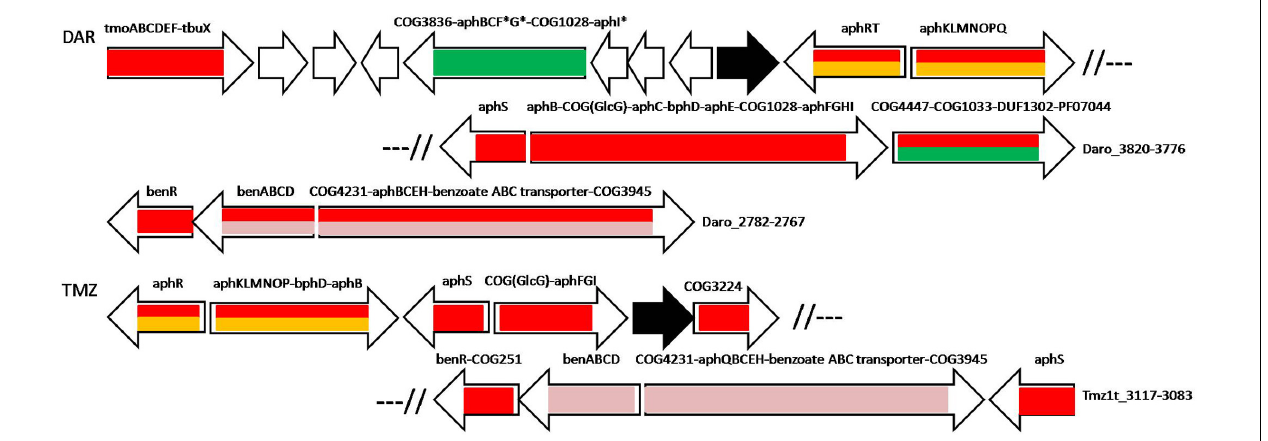
FIGURE 5 | Operon organization and regulation of aromatic metabolism genes regulated by AphS/BphS, AphR, AphT and BenR in D. aromatica RCB and Thauera sp. MZ1T. Color denotes regulation by the following TFs: AphS/BphS – red, AphR – orange, AphT – green, BenR – pink. Double coloring denotes dual regulation. Genes/operons are shown by arrows, black arrows denote pseudogenes. Operons flanked with double slashes belong to the same locus. Genome abbreviations as in Supplementary Table S2